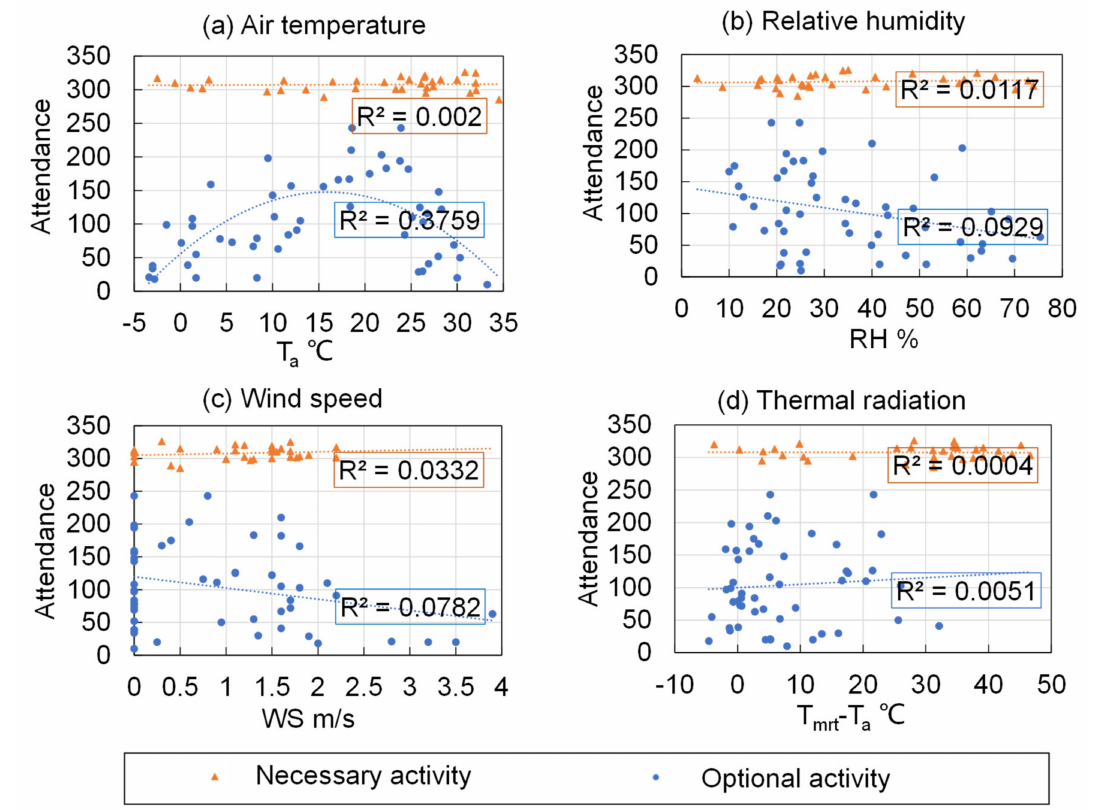
Figure 5. The relationships between different thermal environment parameters and attendance of necessary and optional activities for: ( a ) Air temperature, ( b ) Relative humidity, ( c ) Wind speed, and ( d ) Thermal radiation.